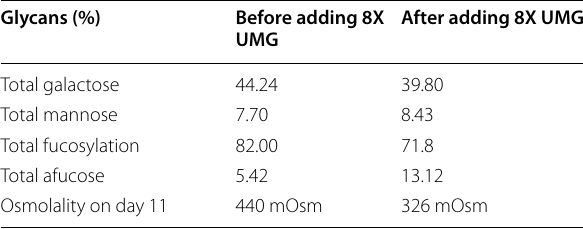
Table 4 Glycan values of test anti-CD20 antibody and